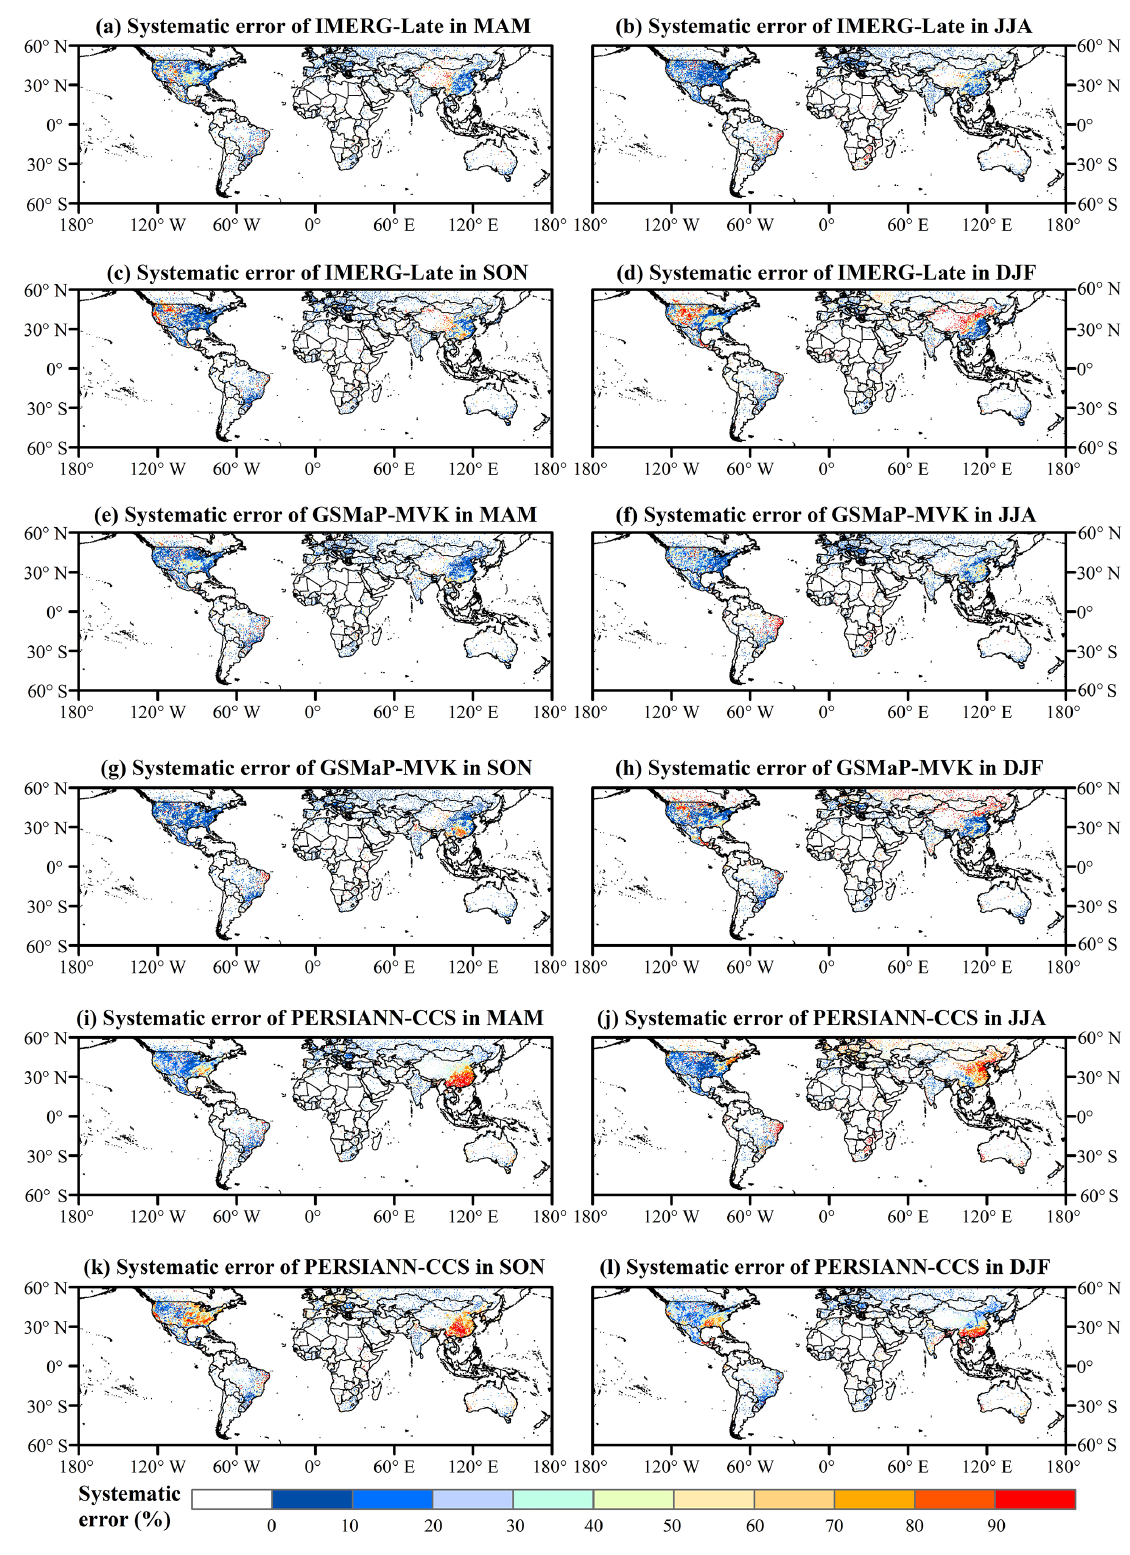
Figure 6. Global land maps of systematic error for the three satellite-only global precipitation estimates (i.e., IMERG-Late, GSMaP-MVK, and PERSIANN-CCS) at a spatial resolution of 0.5 ◦ and daily temporal resolution over the four seasons (i.e., MAM, JJA, SON, and DJF) for the period from 2015 to 2019 (5 years): (a–d) IMERG-Late, (e–h) GSMaP-MVK, (i–l) PERSIANN-CCS.